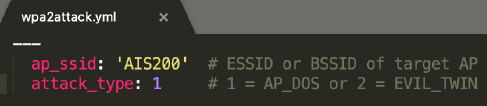
Figure 9. YAML file for a DoS attack.